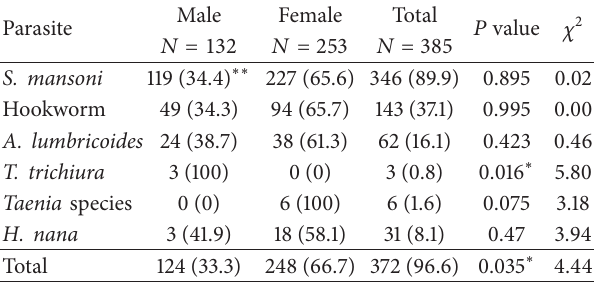
Table 2: Prevalence of S. mansoni and common intestinal helminths by sex among school children in Sanja General Elemen- tary School, Sanja, northwest Ethiopia, 2013.